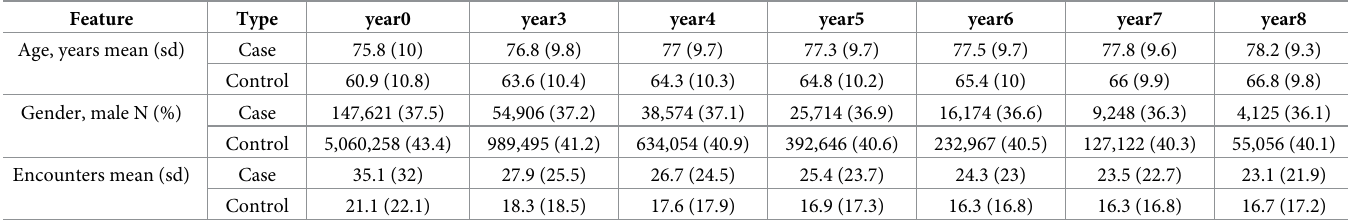
Table 1. Age, gender and number of encounter statistics for cohorts.